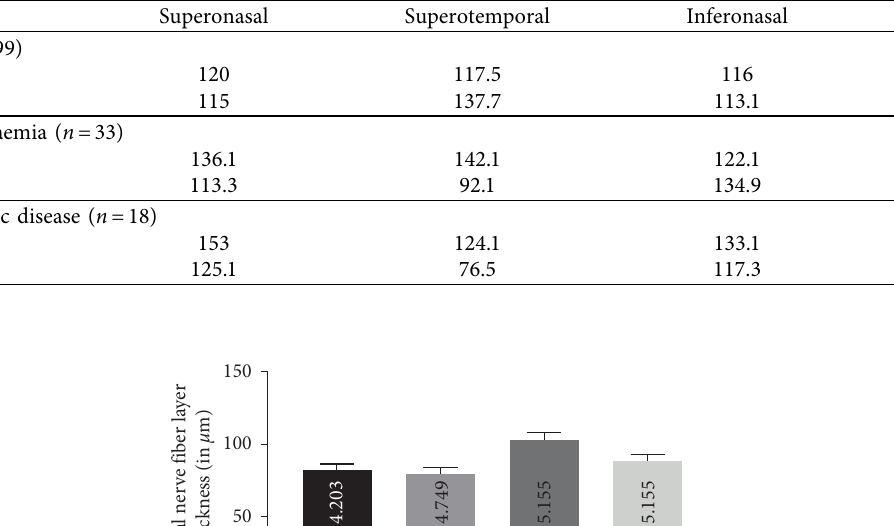
Table 4: Distribution of mean RNFL (in micrometres) for each quadrant of the eye in the study population.